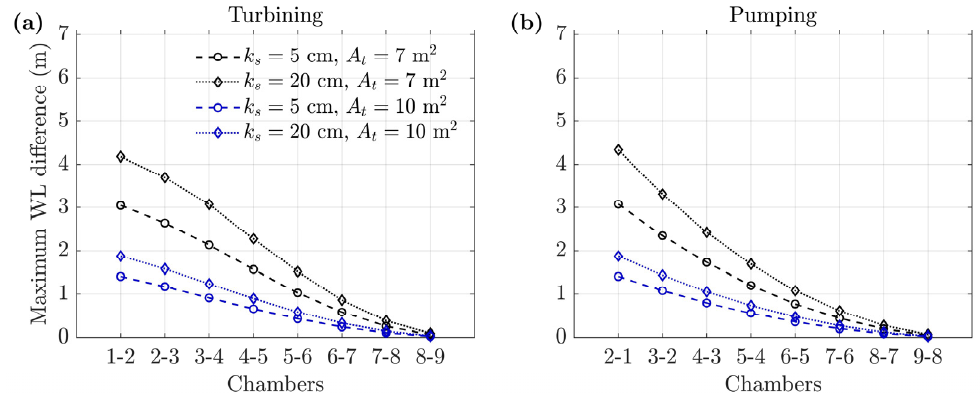
chambers are connected with two galleries. Energies 2020 , 13 , x FOR PEER REVIEW 355